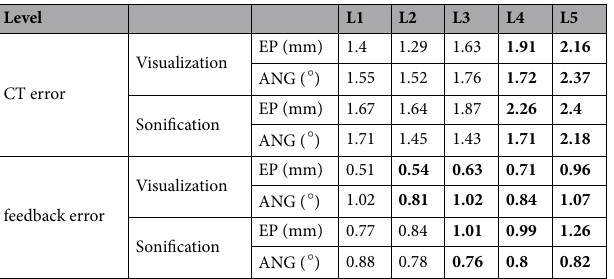
Table 2. The mean error of angle (ANG) and entry point (EP) over the vertebrae levels L1–L5. The bold cells satisfy the safety requirement suggested by Rampersaud et al. 84